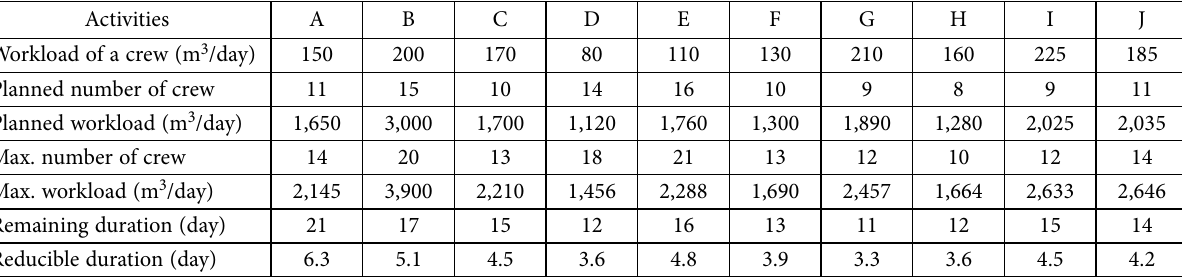
Table 4. The reducible construction duration